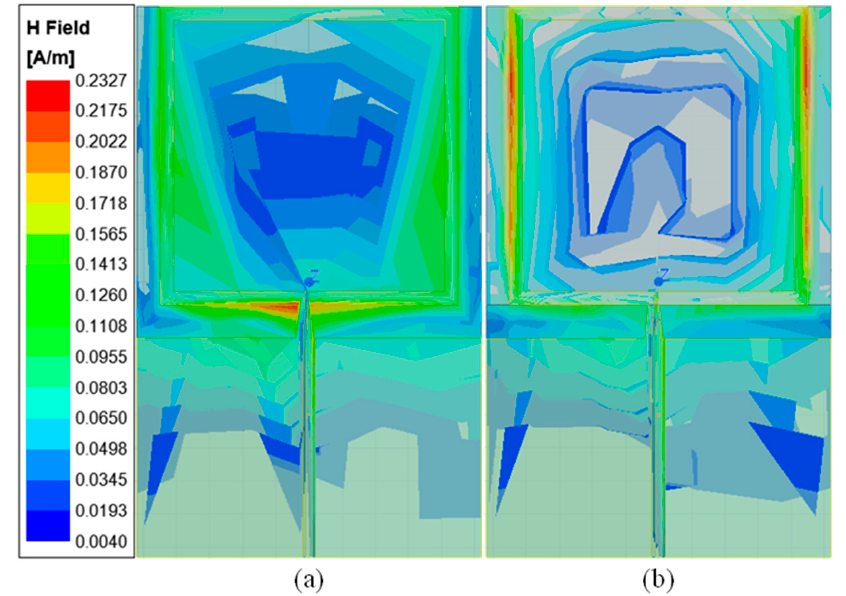
Figure 12. Magnetic field distribution at the top of the magnetic field probe with and without Ni-Zn ferrite sheet. ( a ) Without ferrite; ( b ) with ferrite.